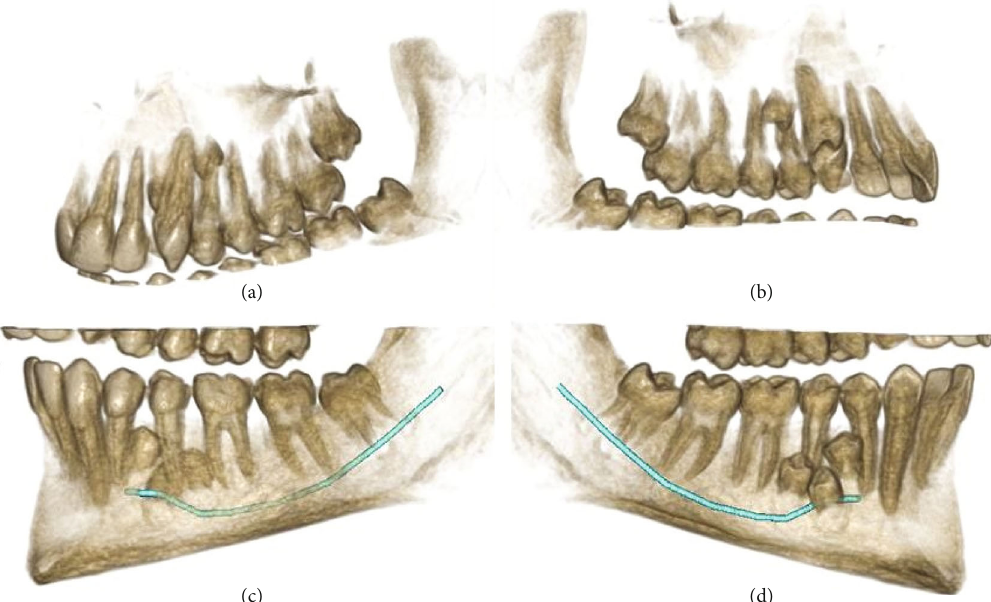
Figure 10: 3D reconstructions of the left quadrants in the maxilla and mandible. (a, c) The buccal view. (b, d) The palatal view. The mandibular nerve canal is